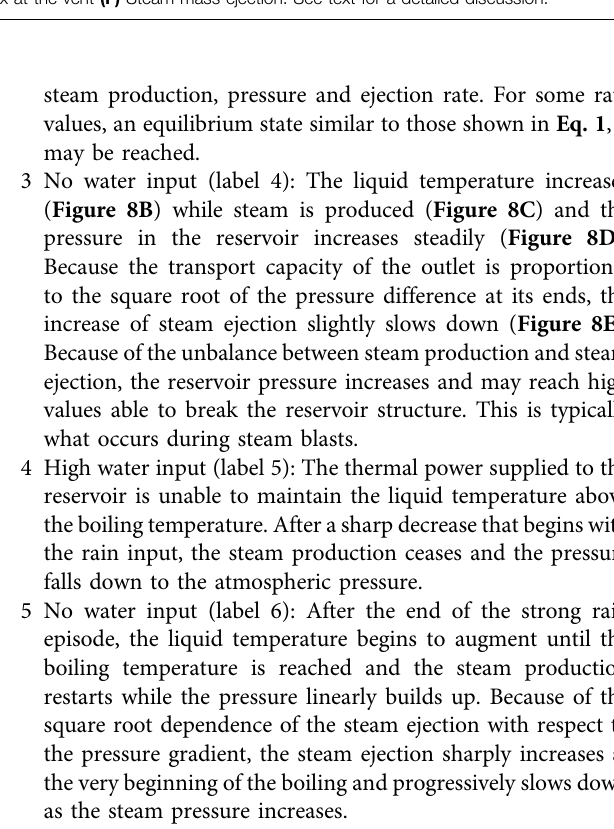
FIGURE 8 | Results of the numerical model corresponding to Figure 7 . (A) Meteoric rain input (B) Temperature of the liquid contained in the reservoir (C) Steam production in the reservoir (D) Steam pressure in the reservoir (E) Steam mass fl ux at the vent (F) Steam mass ejection. See text for a detailed discussion.